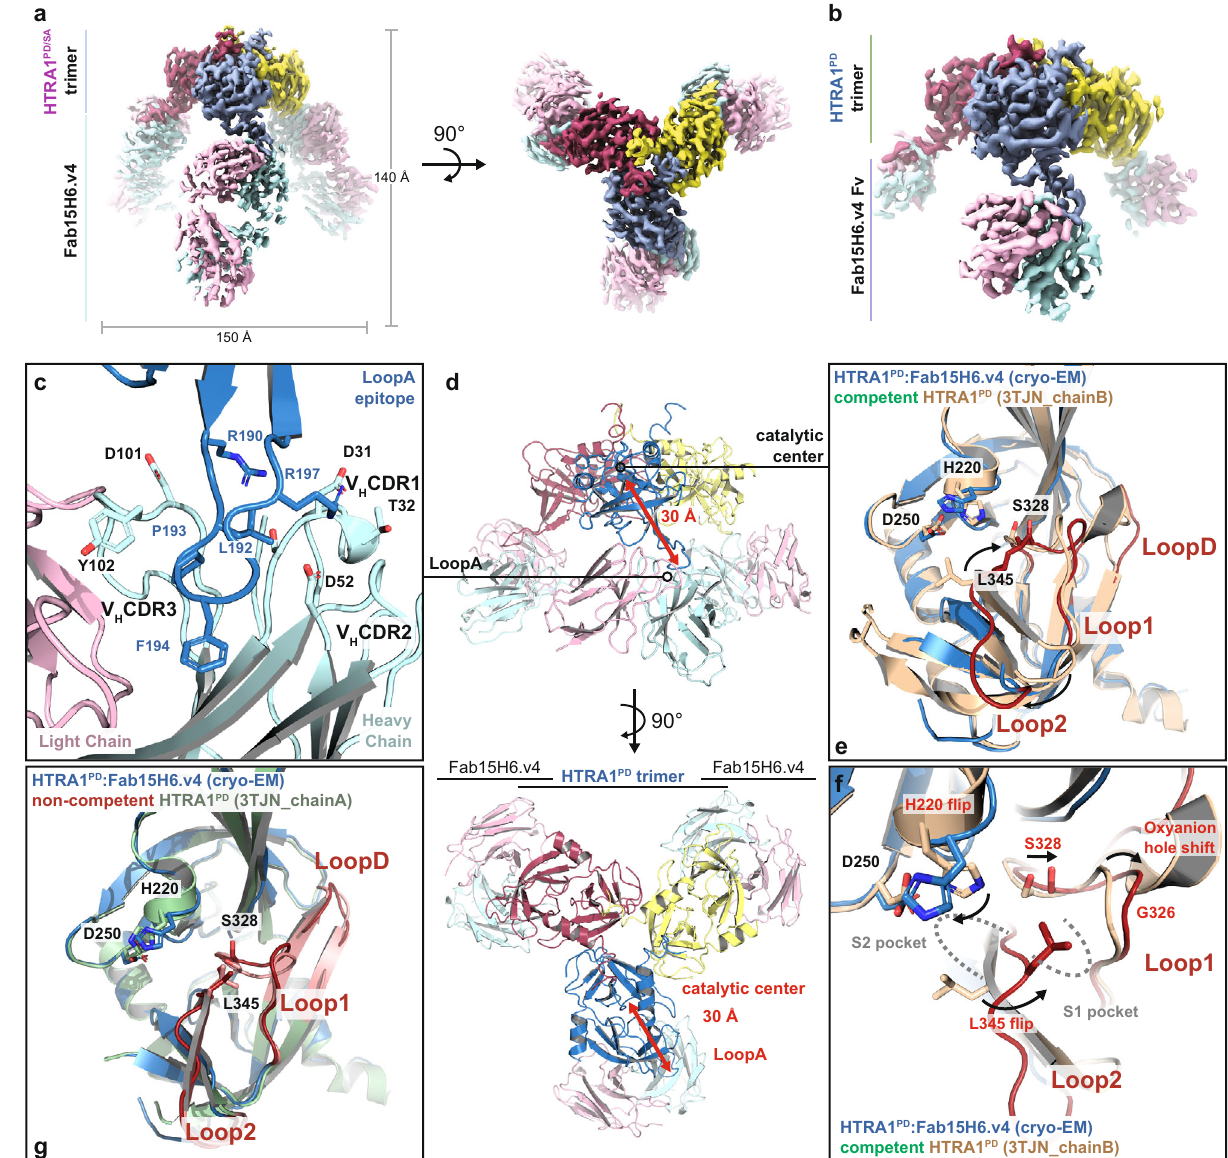
Fig. 2 | Fab15H6.v4 binds to the distant LoopA of the HTRA1 trimer and sta- bilizesanon-competentconformation.a Cryo-EMmapof HTRA1 PD/SA trimerwith three Fabs (Fab15H6.v4) bound to the exposed LoopA at a resolution of 3.3Å. The monomers of the HTRA1 PD/SA trimer are in blue, yellow and red and Fab light and heavy chains are in pink and cyan, respectively. b Cryo-EM map of wildtype HTRA1 PD :Fab15H6.v4 complex at 3.3Å resolution, in which the fl exible constant regions (C H 1/C L ) ofthe Fab15H6.v4 were masked out during re fi nement. c Detailed view on the LoopA epitope and Fab15H6.v4 interaction. Critical residues are represented as sticks. d Ribbon representation of wildtype HTRA1 PD bound by Fab15H6.v4 in side view (top) and top view (bottom). The LoopA epitope is more